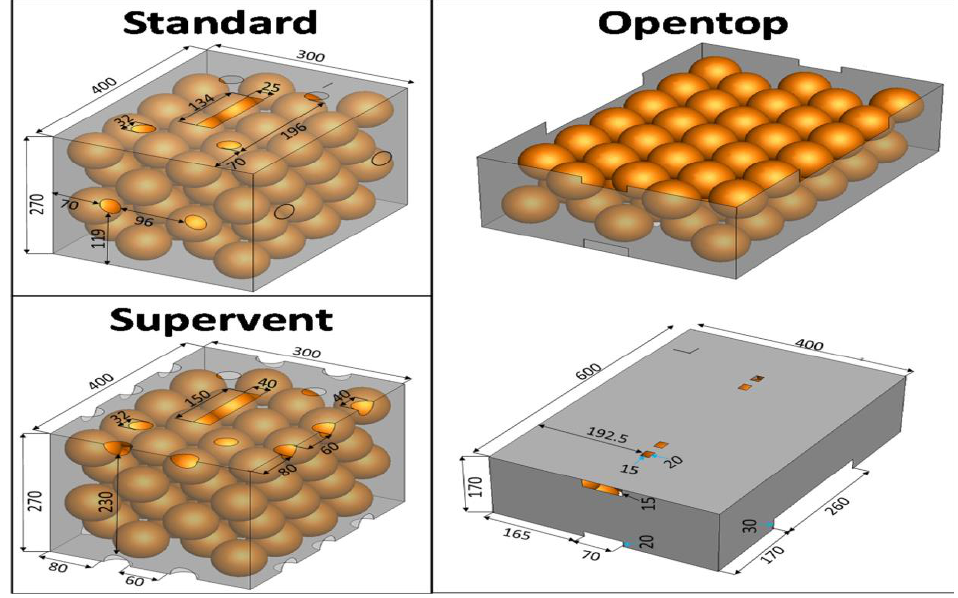
Figure 8. Packaging designs studied by